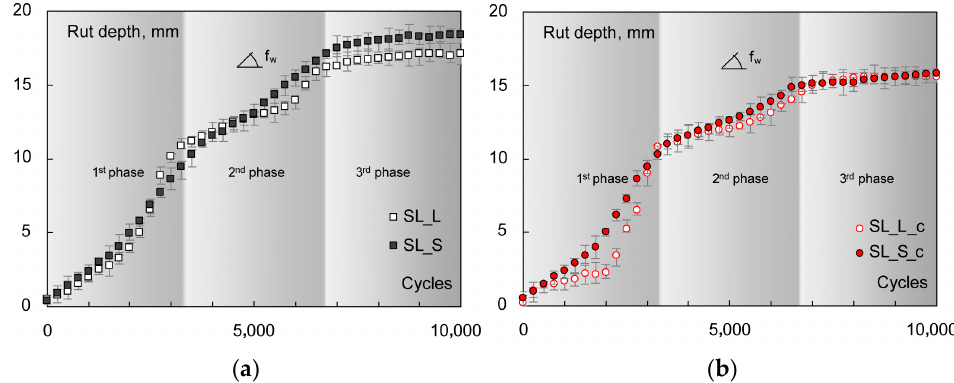
Figure 10. Wheel track results on central slab points: rut depth vs. loading cycles for SL_L , SL_S ( a ) and SL_L_c , SL_S_c ( b ). Table 5. Wheel track results on central slab points: evaluation of creep slopes and final rut depths.